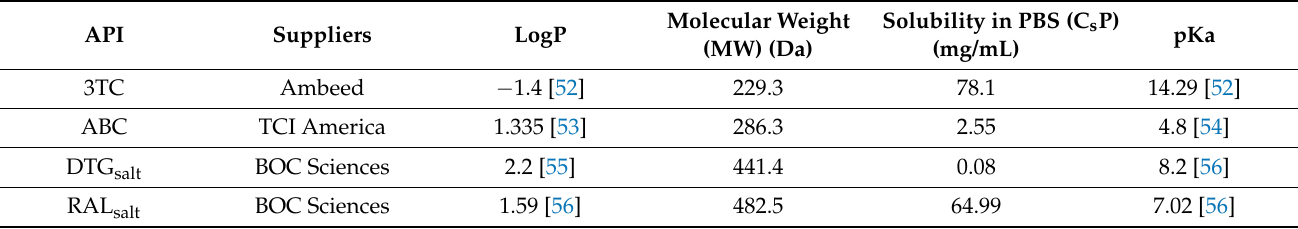
Table 3. Physical properties and sources of APIs for model